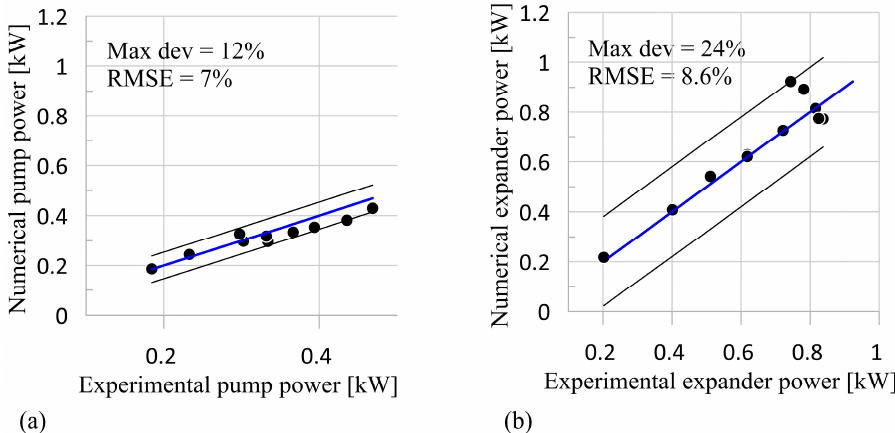
Figure 8. Comparison between the experimental and predicted ( a ) temperature at evaporator inlet;